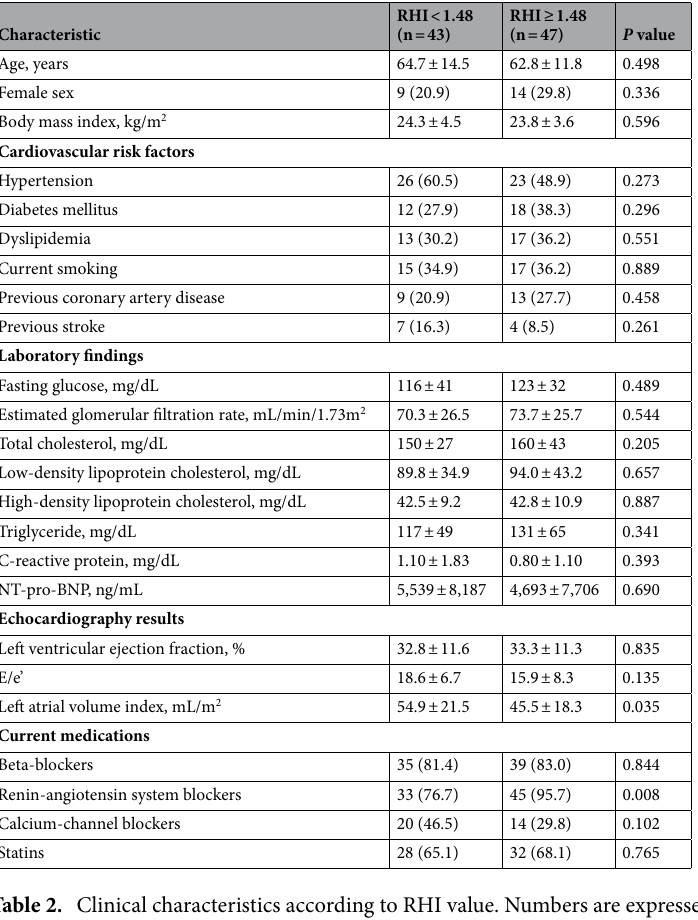
Table 2. Clinical characteristics according to RHI value. Numbers are expressed as mean ± SD or n (%). MACE major adverse cardiovascular event; GFR glomerular filtration rate; NT-pro-BNP N-terminal-pro-brain natriuretic peptide.